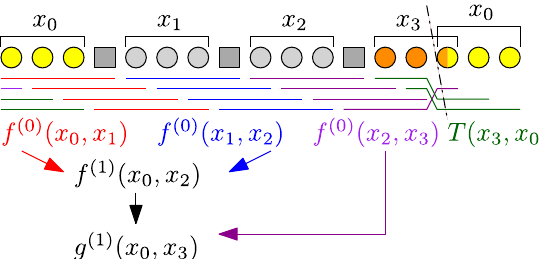
FIG. 3. An example with n ¼ 14 and R ¼ 3 (this corresponds to w ¼ 3 ). Each circle or square corresponds to a party, starting at i ¼ 0 on the left. The dash-dotted line represents crossing the origin and each line below the parties represents a function h (note that h has a range of R þ 1 parties). The lines corresponding to the h ’ s are arranged in groups of R þ 1 (except for the T corresponding to the tail), which we represent with the same color. Each full group contains a single gray square. By minimizing the local deterministic strategy at the square, we can define f ð 0 Þ , which depends on the local deterministic strategy chosen at the R neighbors of each side. These groups of R parties in Fig. 2. They encode the possible d mR local correspond to the x j deterministic strategies for each x . Now, in O ð log n Þ steps we j . Finally, we find the classical bound by find g j w j − 1 ð x 0 ; x w Þ minimizing the sum of g j w j − 1 and T restricted to the x 0 and x w that have a compatible